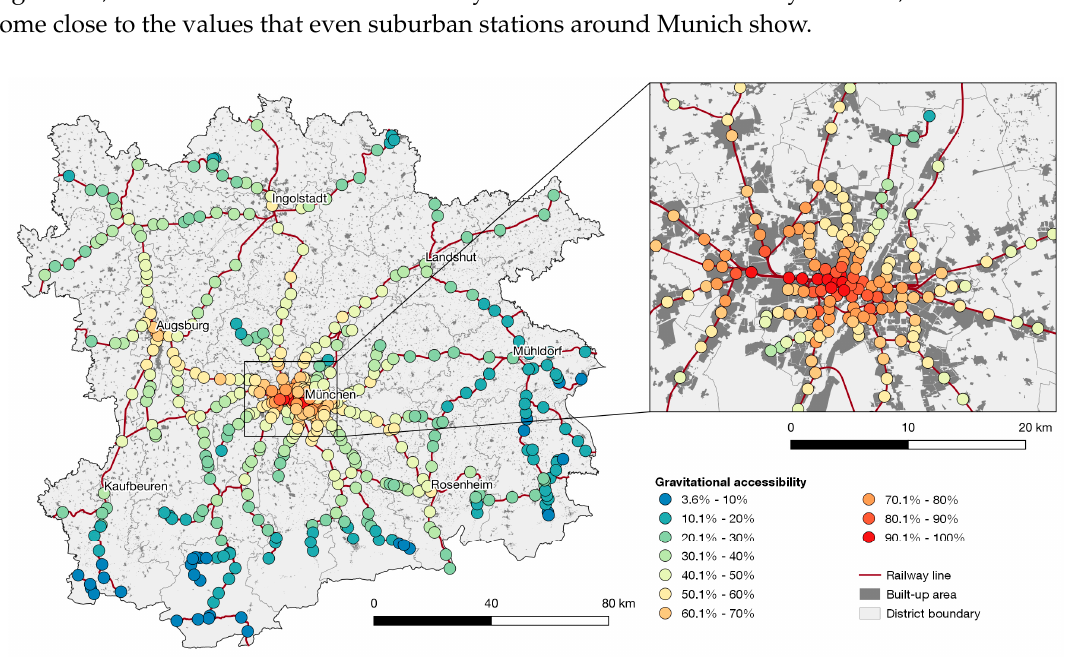
Figure4. Accessibilityofpopulationwithrail-basedpublictransportatrailwaystationsintheMMR2019 Figure 4. Accessibility of population with rail-based public transport at railway stations in the MMR 2019 (Munich main station = 100%) (Source: own work, using geodata by Bayerische (Munichmainstation = 100%)(Source: ownwork, usinggeodatabyBayerischeVermessungsverwaltung, Vermessungsverwaltung, Bundesamt für Kartographie und Geodäsie, Deutsche Bahn). Bundesamt für Kartographie und Geodäsie, Deutsche